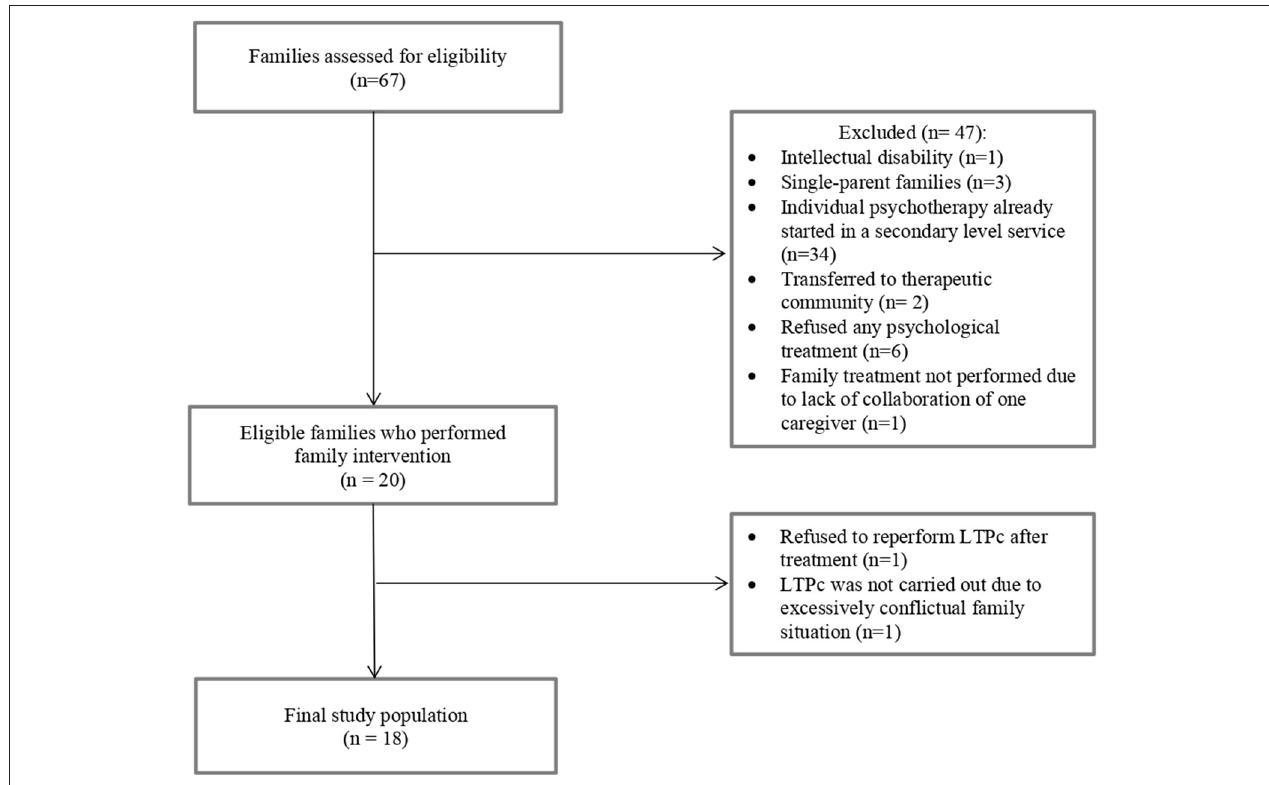
FIGURE 1 | Flow chart of the study